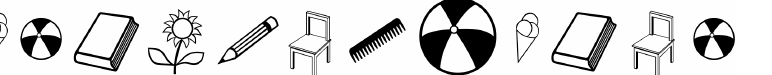
Figure 2. Exemplary trial from the listening comprehension task for the children. “Male ein Kreuz unter das Buch, das neben einem Stuhl liegt” (“Draw a cross under the book that is next to the chair”). Subjective disturbance was assessed using a smiley scale with 4 points representing the ratings “not at all disturbed” (0), “a little disturbed” (1), “strongly disturbed” (2), or “extremely disturbed”